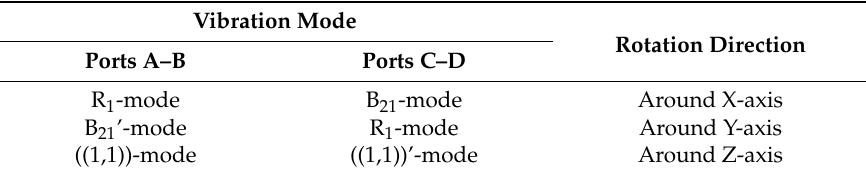
Table 2. Operation method of each rotation.